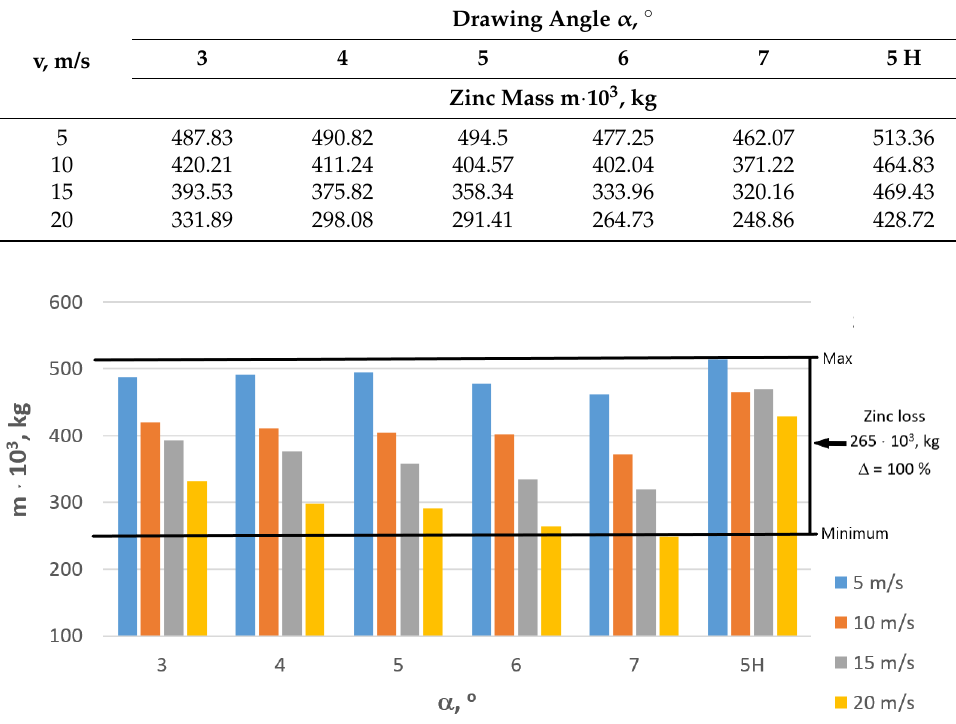
Figure 16. Influence of the technology of wire manufacturing on the mass of zinc coating in relation to 100,000 tons of steel wire drawn with speed v=5, 10, 15, 20 m/s. Experimental research conducted in an industrial production facility demonstrated that the technology of wire manufacturing significantly influences the thickness of the zinc coating and the volume of lost zinc, with the differences between the analyzed vari- ants amounting to 265 tons. This is corroborated by the results presented in Table 5, and Figure 16 which demonstrate a causal relationship between the increase in drawing speed and the angle of the contact zone of a drawing die and the increase of zinc loss, which also translates to increased CO 2 emissions. According to Idemat, the production of 1 kg of pure zinc generates 3.33 kg of CO 2 . This, in turn, means that the annual production of wire referred to herein results in the emission of almost 900 tons of CO 2 ; Figure 17.